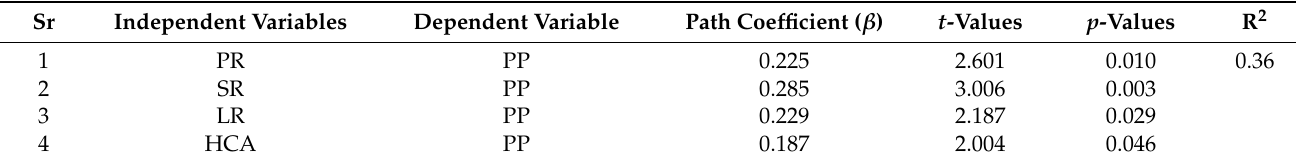
Table 8. Main effects analysis for